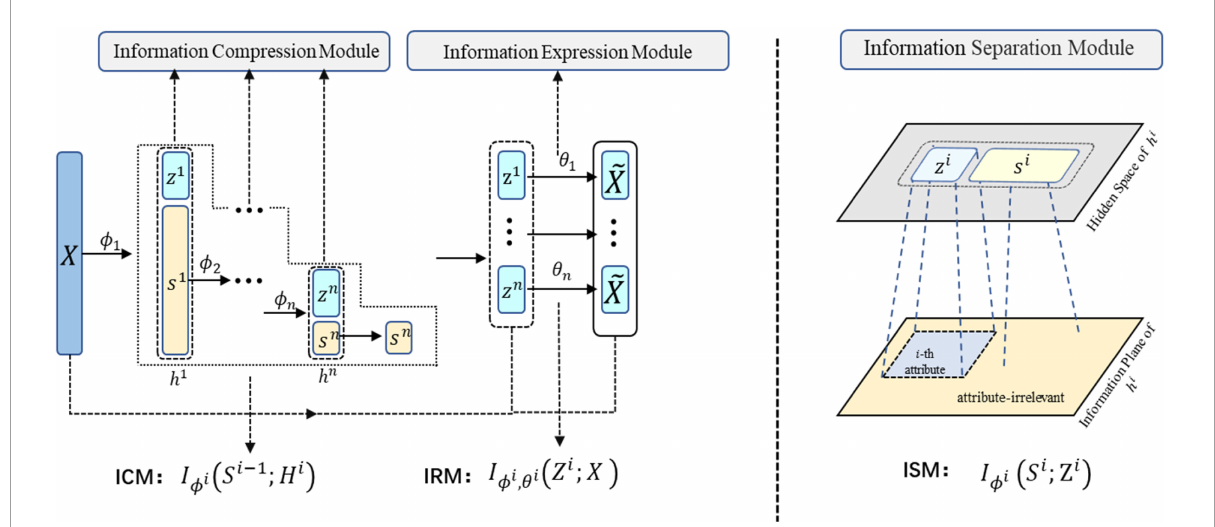
FIGURE1 The diagram of Layer-wise Feature Extraction Algorithm (LFEA). LEFA contains three core modules: Information Compression Module (ICM), Information Expression Module (IEM) and Information Separation Module (ISM), to ensure compression, expression and disentanglement of representation,